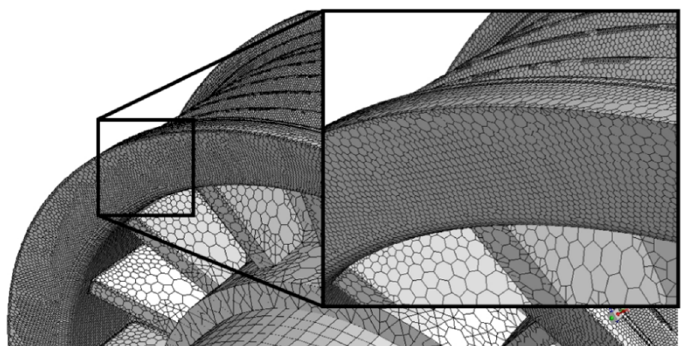
Figure 9. Polyhedral mesh for the numerical analysis.